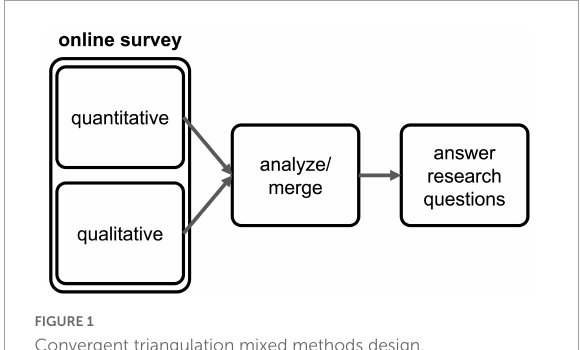
FIGURE1 Convergent triangulation mixed methods